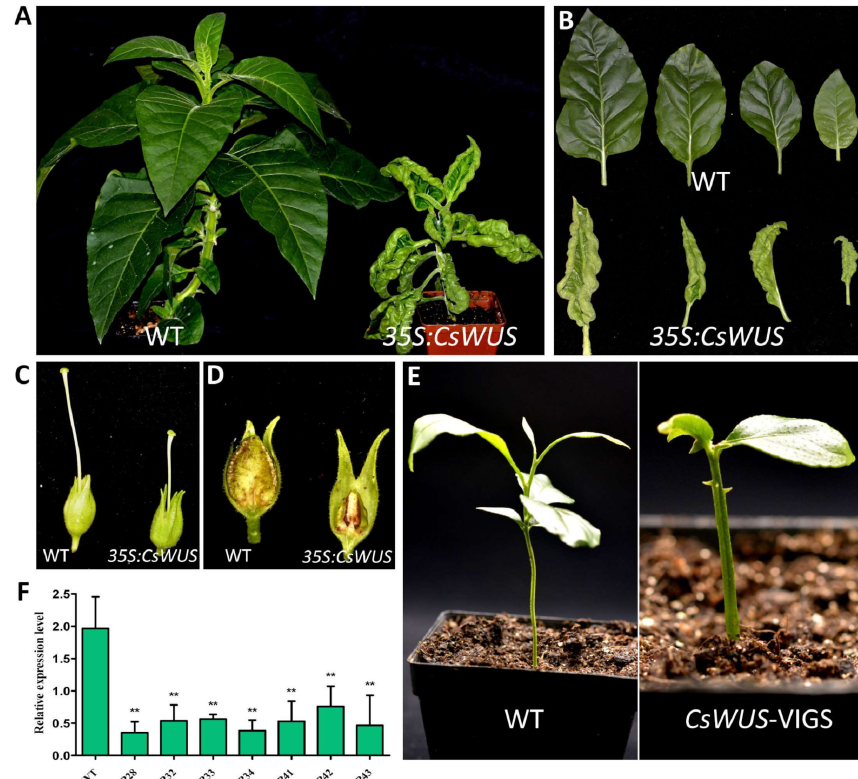
Figure 5. Phenotype analysis of CsWUS overexpression in transgenic tobacco and virus-induced gene silencing (VIGS) in lemon. ( A ) Phenotype, ( B ) leaf morphology, ( C ) flower gynoecium, and ( D ) seed pods of control and CsWUS transgenic tobacco. ( E ) Representative phenotypes of wild-type (WT) and CsWUS silencing induces thorn development in lemon. ( F ) Relative expression levels of gene silenced and control plant. CsActin was used as internal control; mean ± SD of three biological replicates is presented. Asterisks indicate significant differences: ** p <